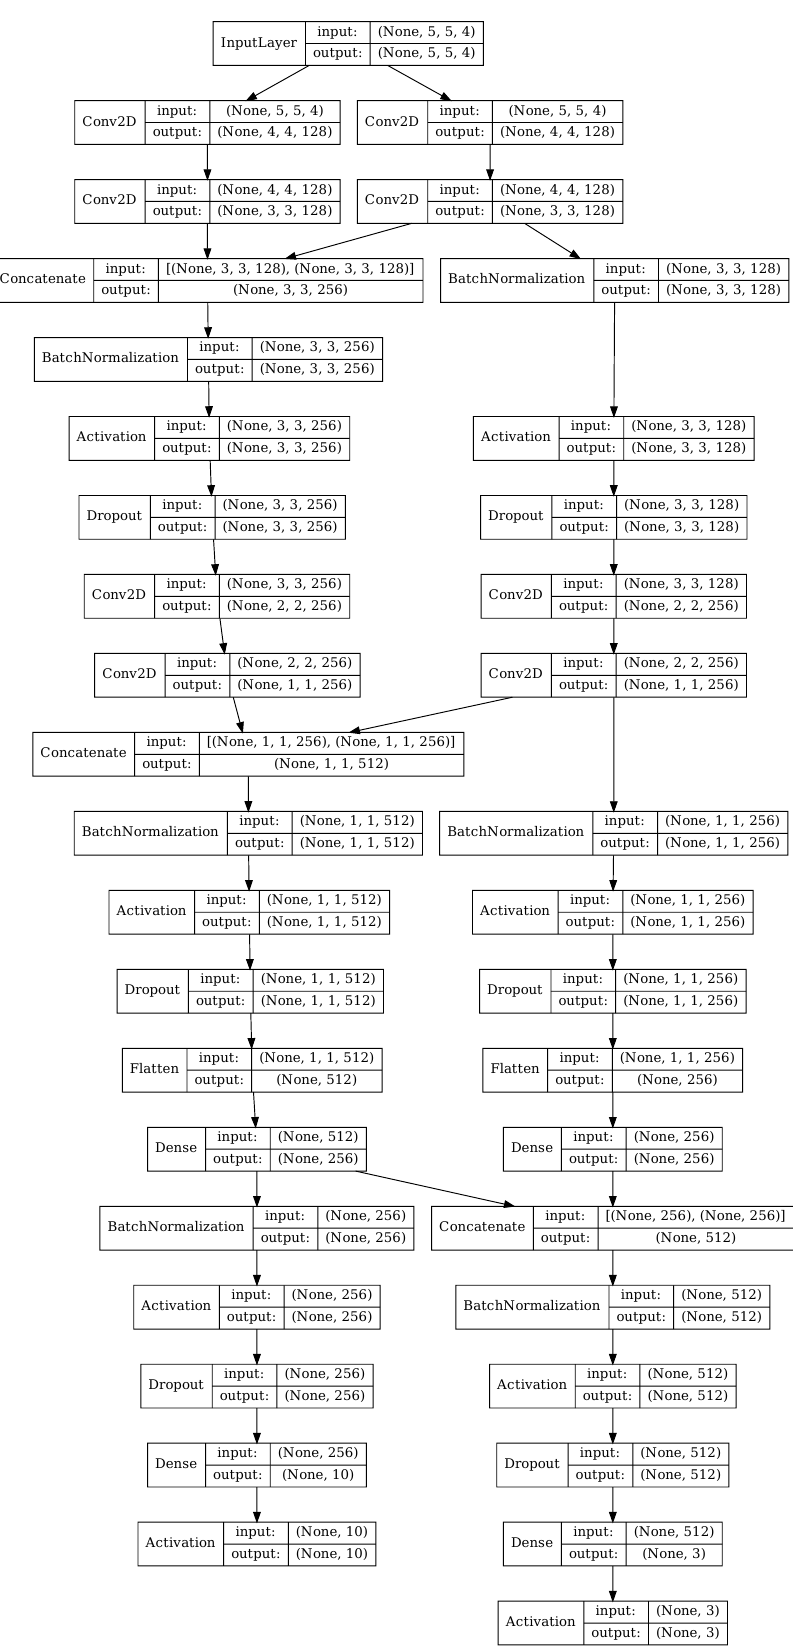
Figure 3. A two-branch dual output CNN topology for image